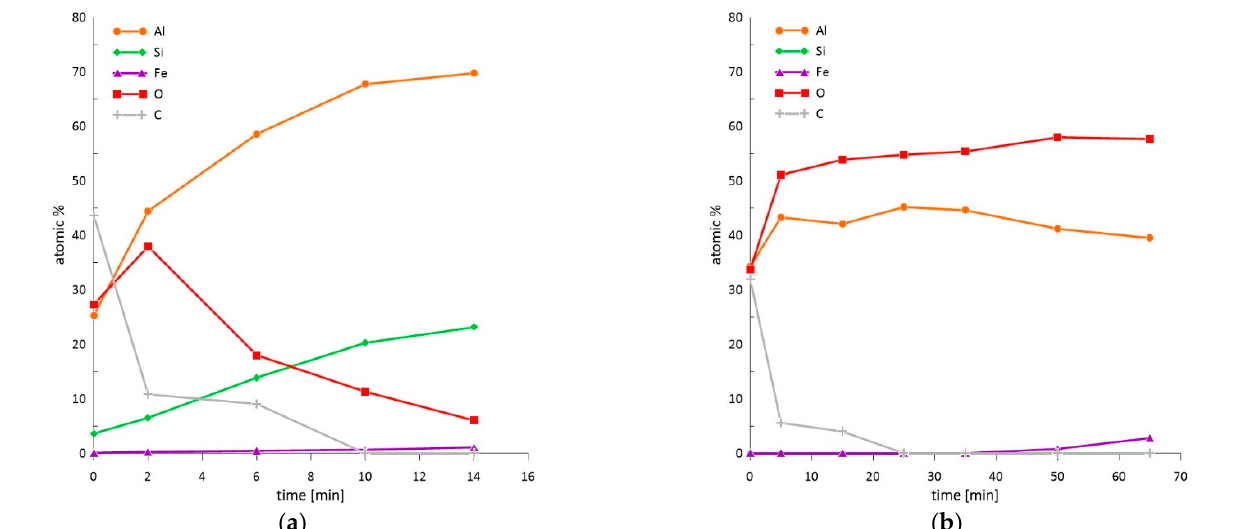
Figure 12. XPS depth profiles of ( a ) the chemical composition of the as-received 22MnB5 boron steel in the hot-dipped condition and ( b ) the die-quenched 22MnB5 boron steel.